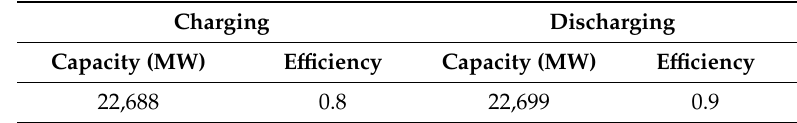
Table 3. Parameters for Pumped Hydro